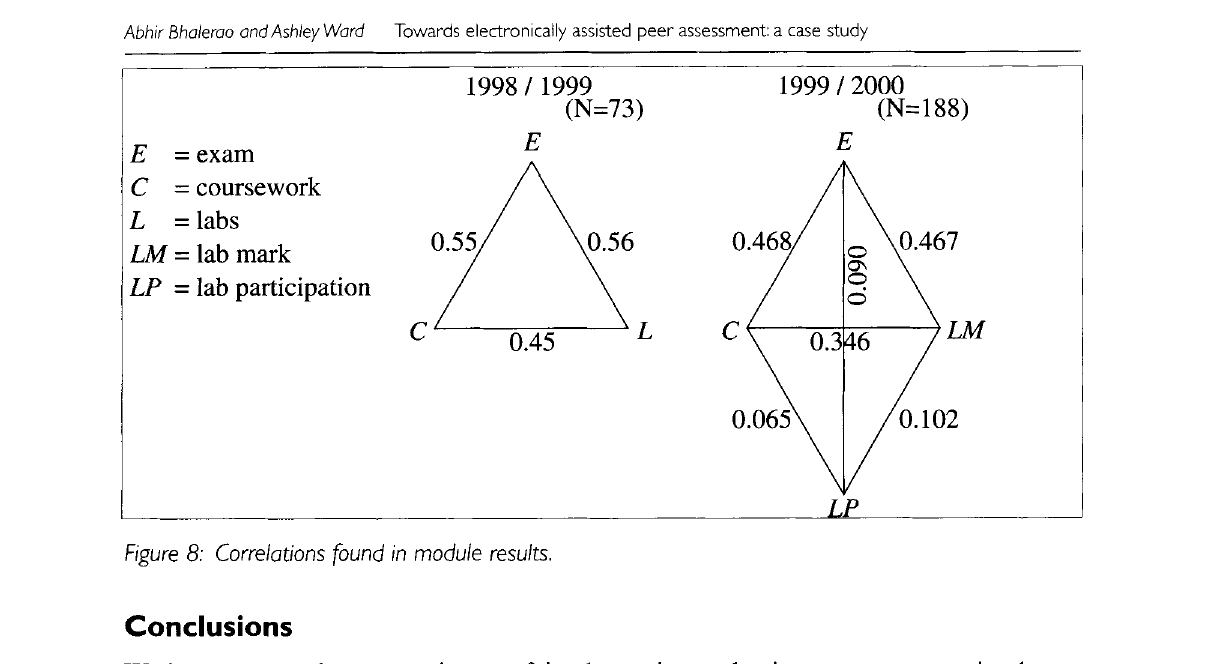
Figure 8: Correlations found in module